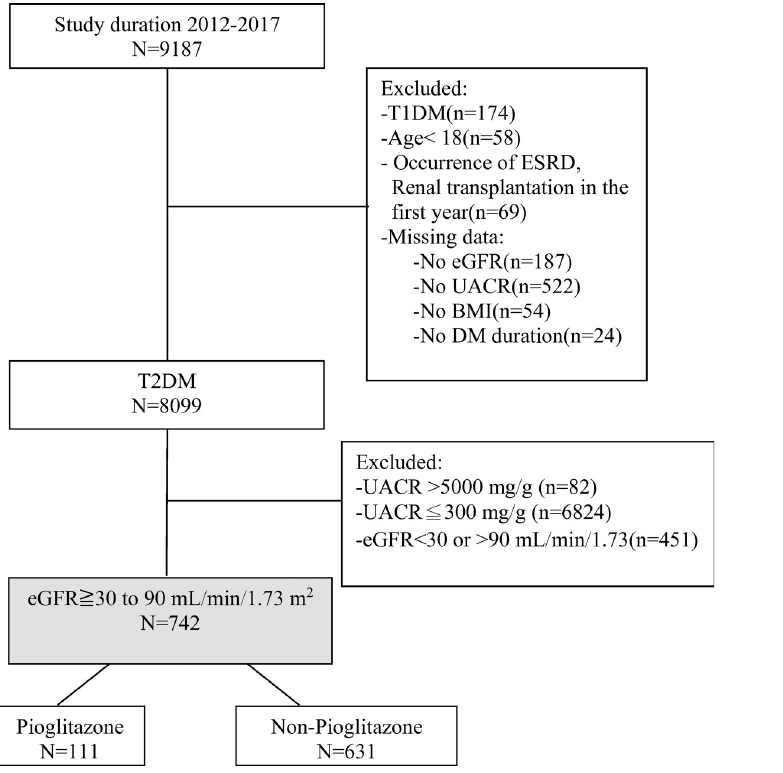
Fig 1. Detailed flow chart of patients’ inclusion and exclusion criteria in this